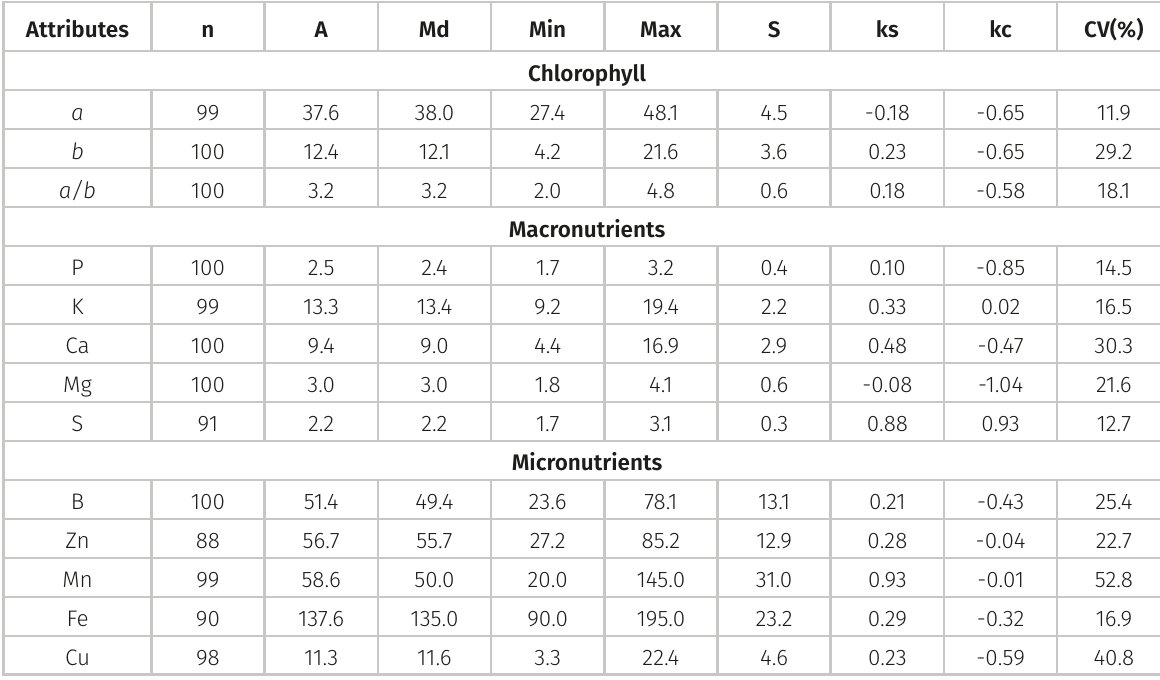
Table III. Descriptive analysis of the attributes: Chlorophyll a , b and a/b (LCI), macronutrients and micronutrients leaf of the rubber